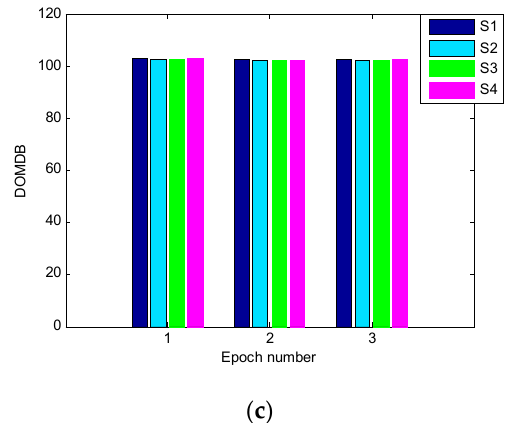
Figure 3. The comparison of POP and DOMDB of three different epochs under the new satellite geometry. ( a ) Sky plot view of the new satellite geometry; ( b ) POP; ( c ) DOMDB.